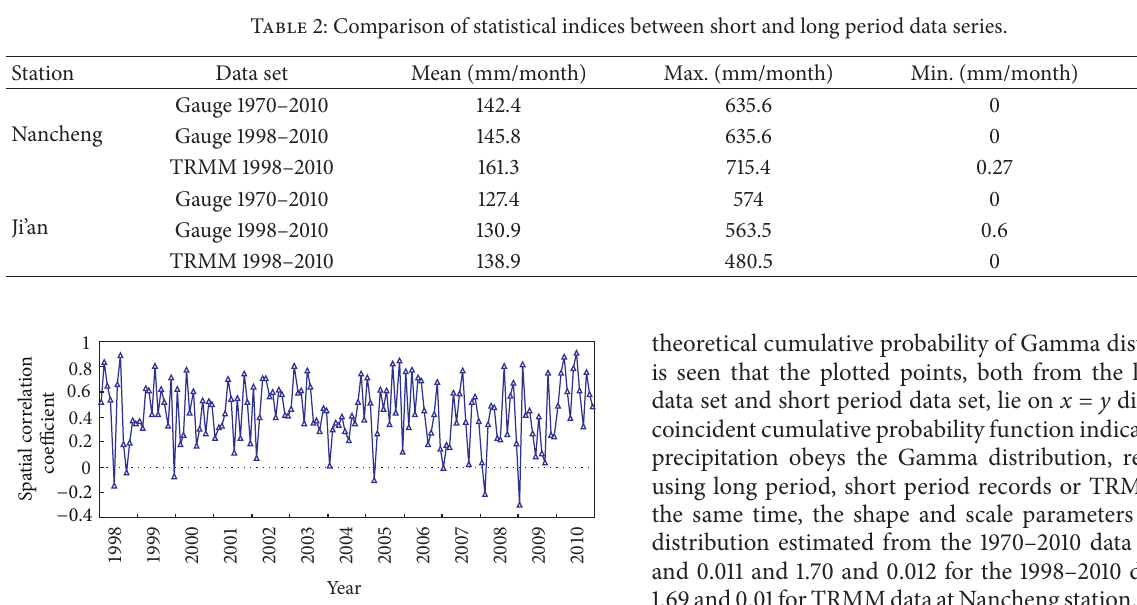
Figure 7: Variation of spatial correlation between TRMM and interpolated gauges